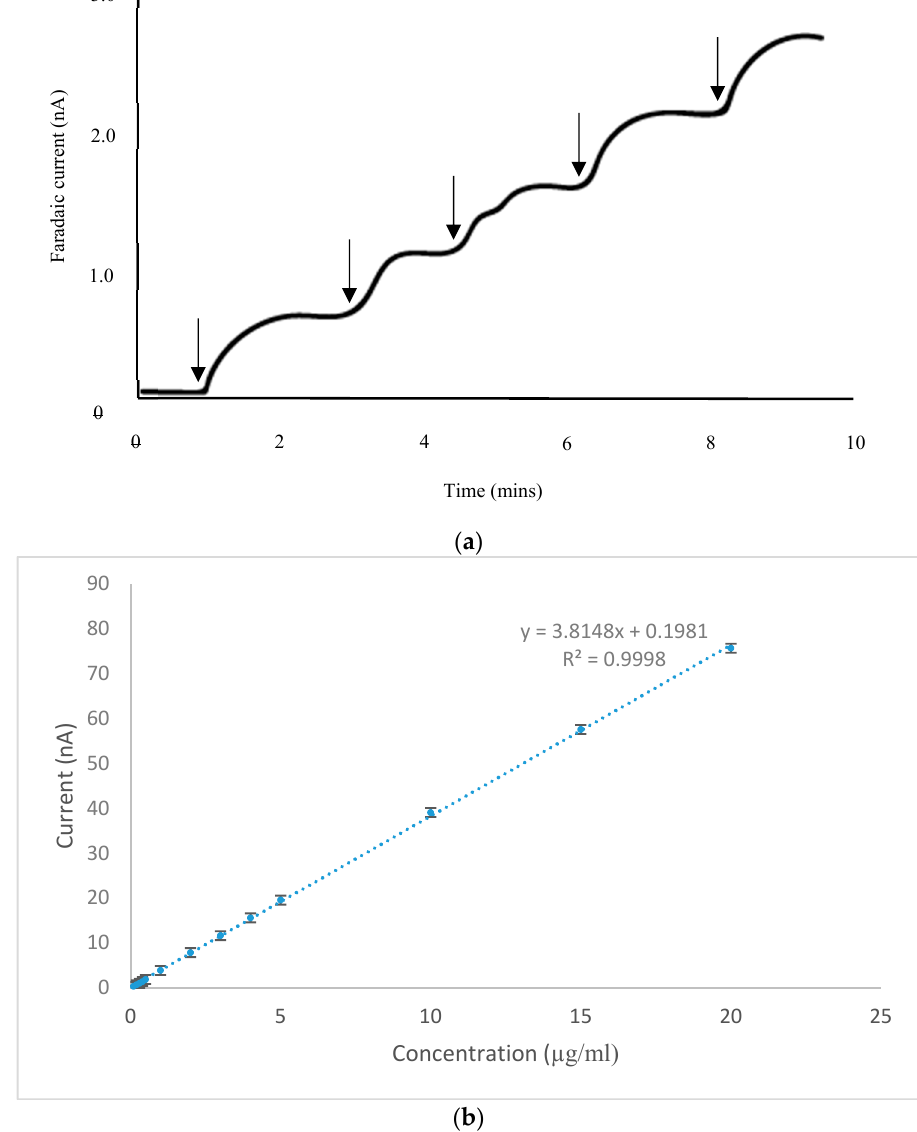
Figure 6. ( a ) Amperometric responses obtained with a CoPC-SPCE sensor following additions of 10 µL of a vitamin B1 standard (100 µg mL − 1 ) into 10 mL of stirred 0.1 M pH 12 PBS. Arrows indicate the point of addition of the standard. ( b ) Calibration study for vitamin B1 generated using amperometry in stirred solution with a CoPC-SPCE sensor.